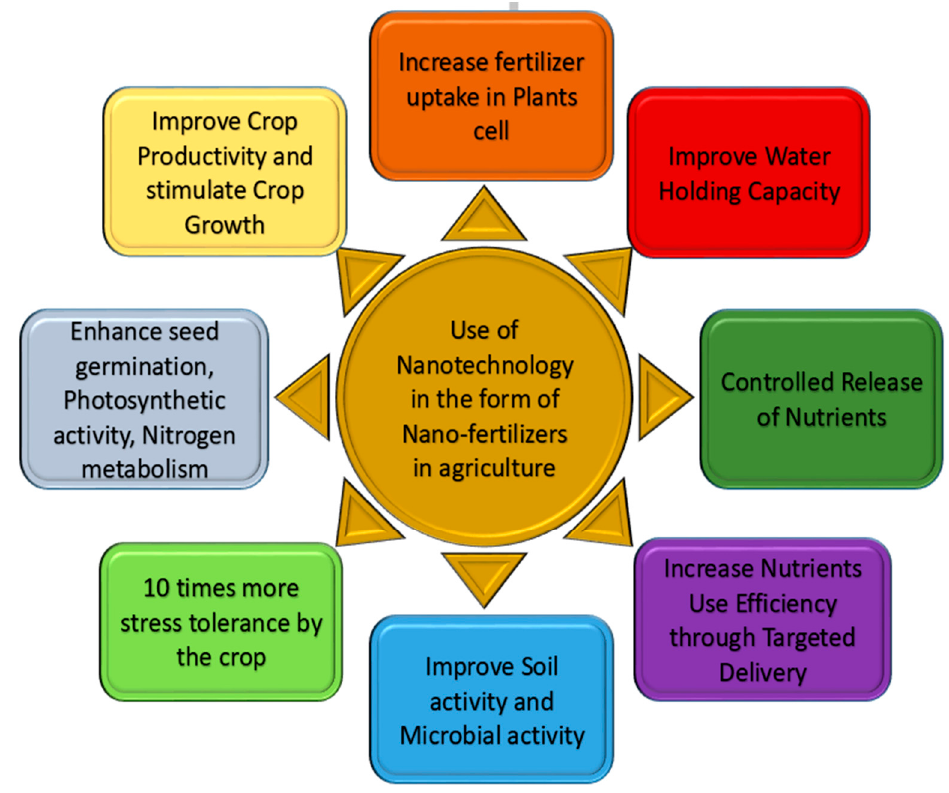
Figure 3. Different applications of nanobiofertilizers in the field of agriculture.